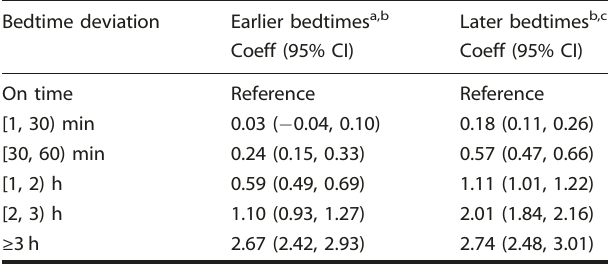
Table 4. Within-person differences in average resting heart rate during the next day across bedtime